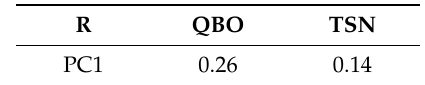
Table 8. Correlation coe ffi cients (R) between PC1 and the low-frequency climate indices (bold font indicates statistically significant values at the 5%